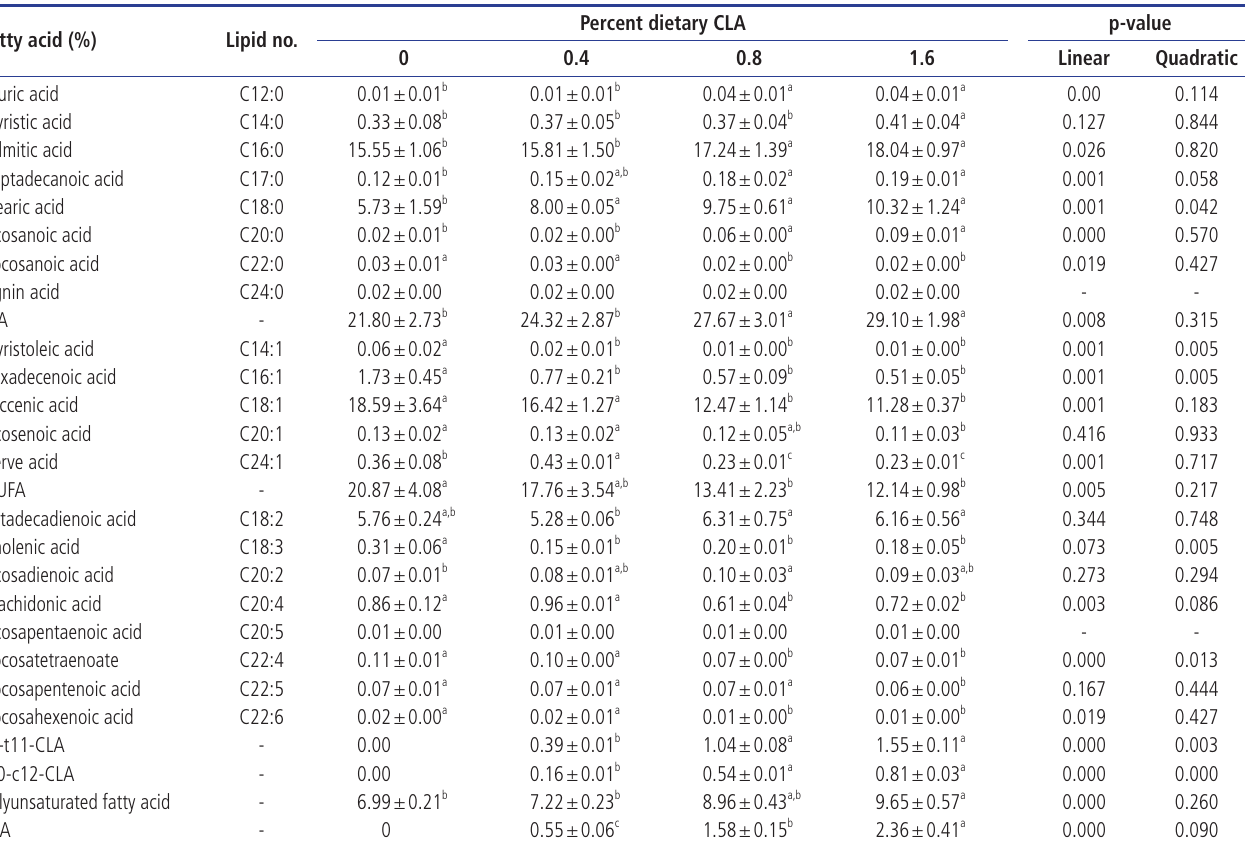
Table 6. Fatty acid composition of egg yolk 1)